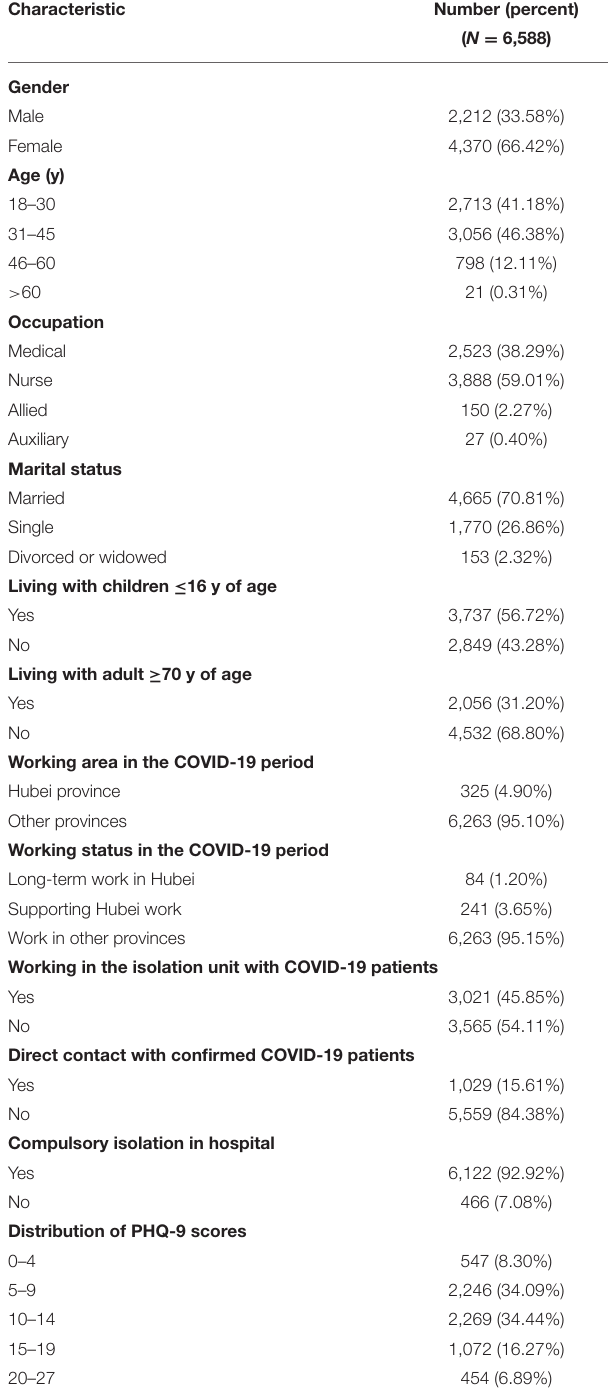
TABLE 1 | Participant